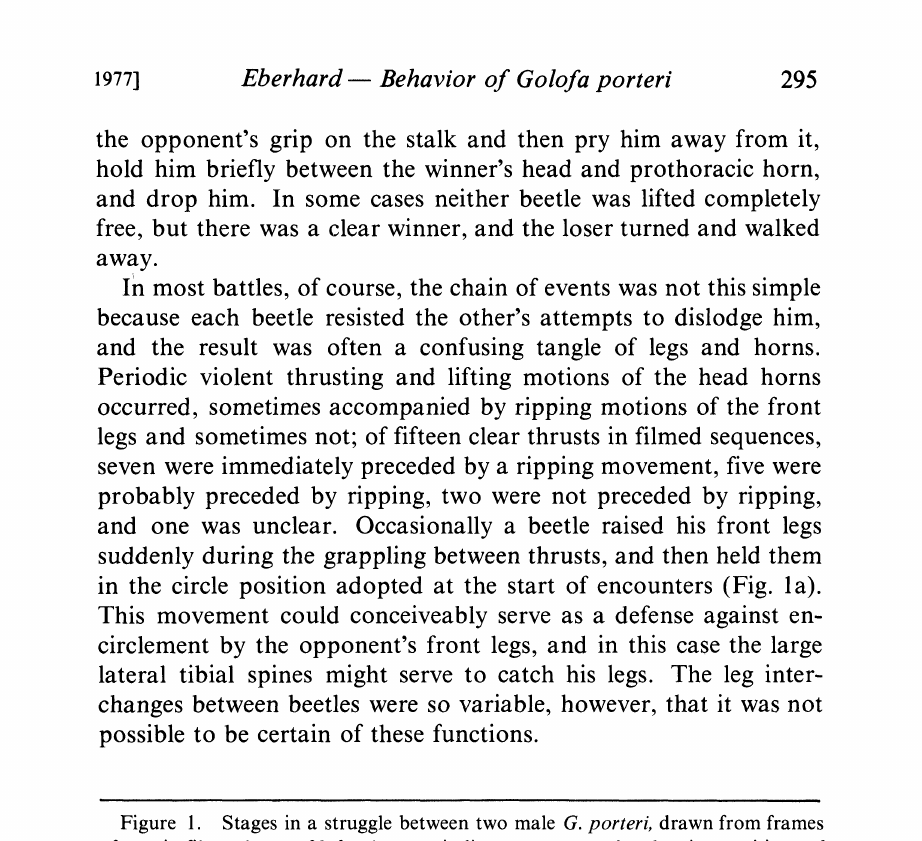
Figure 1. Stages in a struggle between two male G. porterL drawn from frames of movie film taken at 30 fps (arrows indicate movement by showing positions of legs, etc. in the next frame), a) The upper male has encircled the stalk with his front legs. In the next frame he made an apparent threat by abruptly raising his legs slightly, and then (in the following frame) lowering them again, b) Each beetle has inserted his lowered head horn under the opponent, and, while holding the stalk tightly with his middle and hind legs, is "embracing" the opponent with his front legs (note how the elongate legs just fit the length of the other beetle’s body), c) The lower beetle has just executed the ripping motion with his front legs, dislodging his opponent’s left middle and hind legs, and is about to (next frame) flex his head dorsally to pry the opponent away from the stalk. His head horn was not under the central part of the upper beetle’s body but was somewhat to the right (as seen in the drawing), and the attack was not successful since the opponent managed to keep his right rear foot hooked to the stalk. (The upper beetle’s left middle and left rear legs were out of the focal plane, and their positions are estimated in the drawing from shadows cast on the stalk and from other lifting sequences. The lower beetle’s head horn was not distinguishable in the next frame, presumably be- cause it was moving so fast, but was clear (the head flexion had finished) in the following frame; its movement (arrow) was estimated by halving the distance be- tween its position prior to and after the